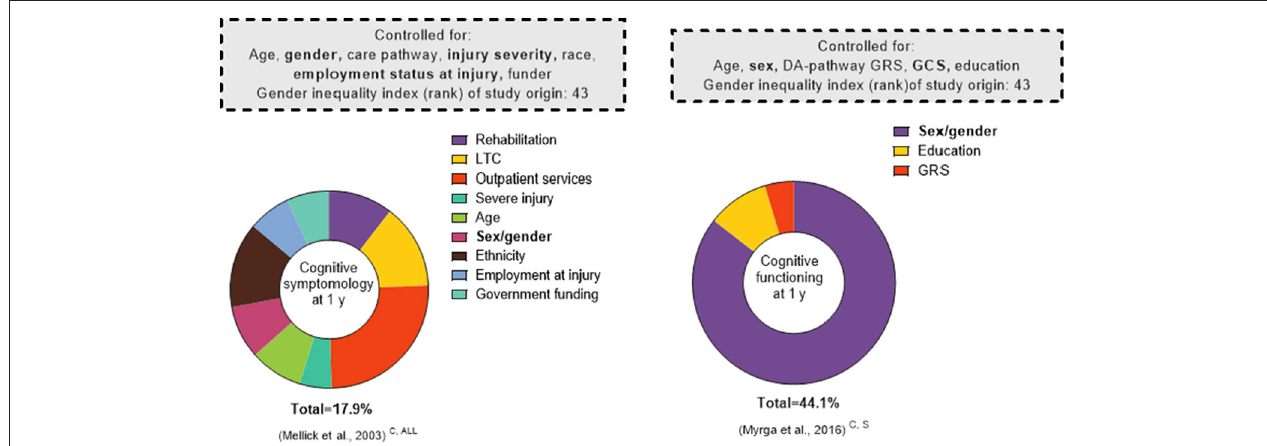
FIGURE 6 | Effect sizes of explained factors/variance investigated in relation to post-TBI outcomes in multivariate regression analyses. This figure represents select findings for comparative purposes (all outcomes available in Supplementary Figure 5 ). All analyses included sex/gender. For the * outcomes, the proportions correspond to the partial R 2 . For all other outcomes, the proportions correspond to the β coefficients. Total corresponds to the total variance explained by the model (R 2 ). Only statistically significant factors are included as explaining variance, given that the cutoff p -values were not consistently reported. The superscript letters indicate post-injury phase (A, acute; C, chronic; and NR, not reported) and injury severity (M, mild; M-S, moderate-to-severe; S, severe; and ALL, all severities). The bolded factors in the “Controlled for” boxes indicate those that have been linked to sex and/or